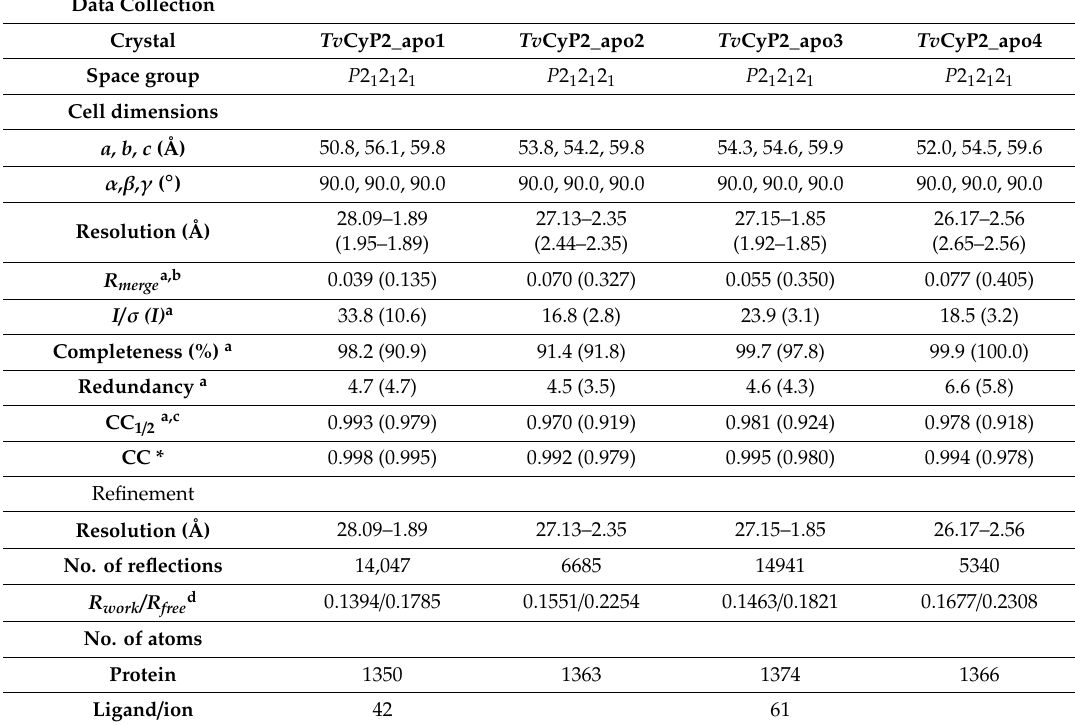
Table 1. Data collection and refinement statistics of X-ray structures of Tv